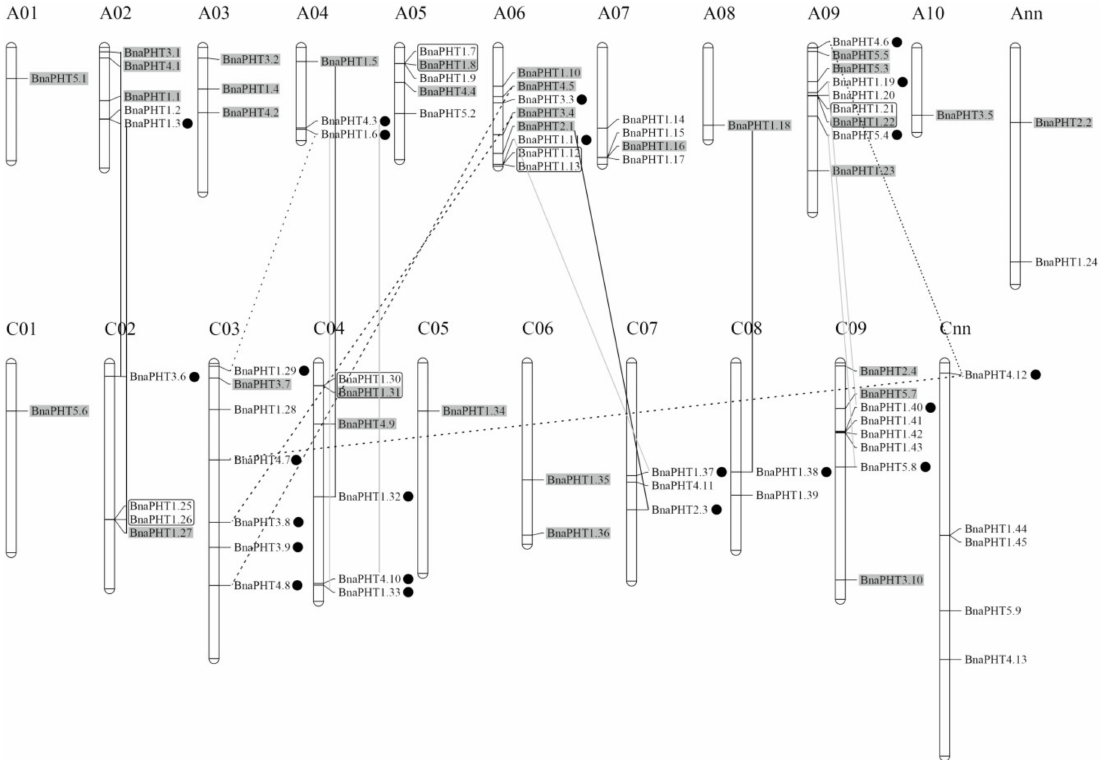
Figure 4. Distribution of PHT genes on B. napus chromosomes. The 81 BnaPHTs were mapped on the 19 chromosomes, except for seven genes. The Ann and Cnn chromosomes represent the chromosomal fragments mapped to A n or C n subgenome respectively, but the locations of these are as yet unclear. The genes in the gray background were originated from the whole genome duplication event (WGD). The black, gray and dashed lines represent the genes involved in homologous exchange (HE), segmental exchange (SE), and segmental duplication (SD) events with the new duplicated genes are marked in black dot, respectively. The genes in the black box represent tandem duplication (TD)